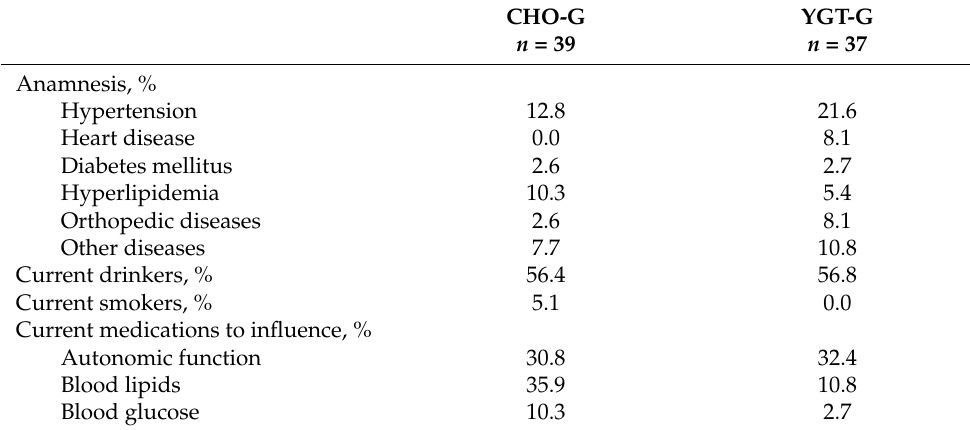
Table 2. Past and current health status of participants.